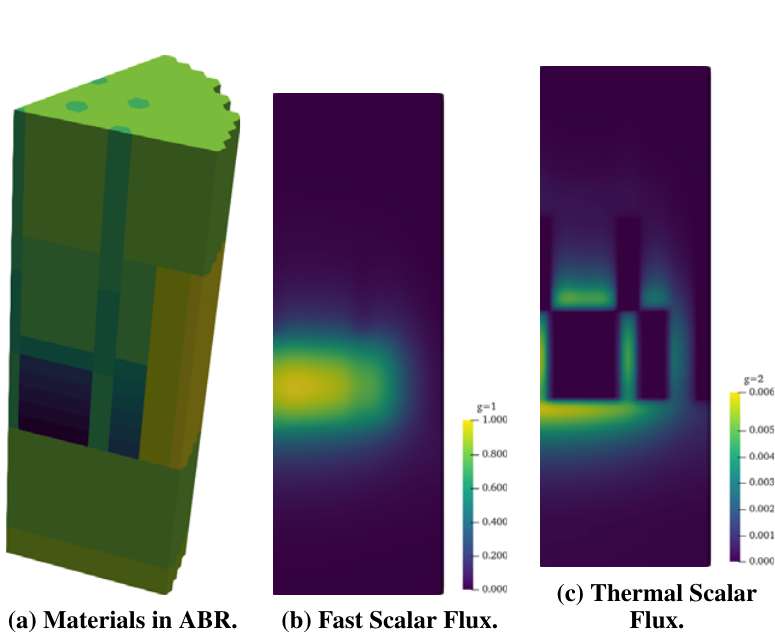
Figure 4: Fast and Thermal Neutron Flux in